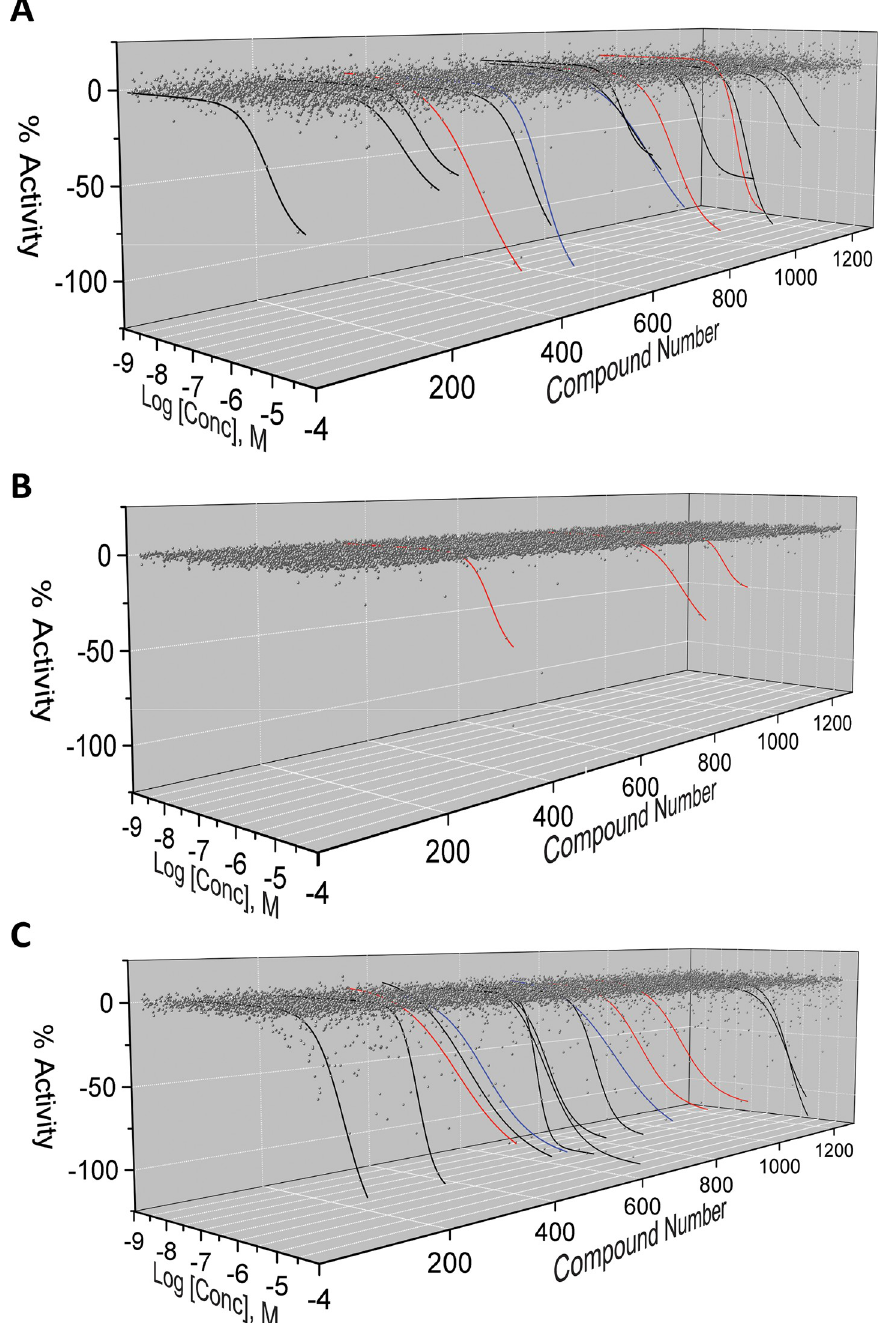
Fig 8. qHTS activity plots for LOPAC compounds. Results shown using (A) CisBio, (B) LANCE, and (C) AlphaScreen assays. Concentration response curves fit to data of active compounds using a 4-parameter logistic equation are included with solid lines. Black lines indicate activity only within the indicated assay. Blue lines indicate activity in both CisBio and AlphaScreen assays. Red lines indicate activity in all three